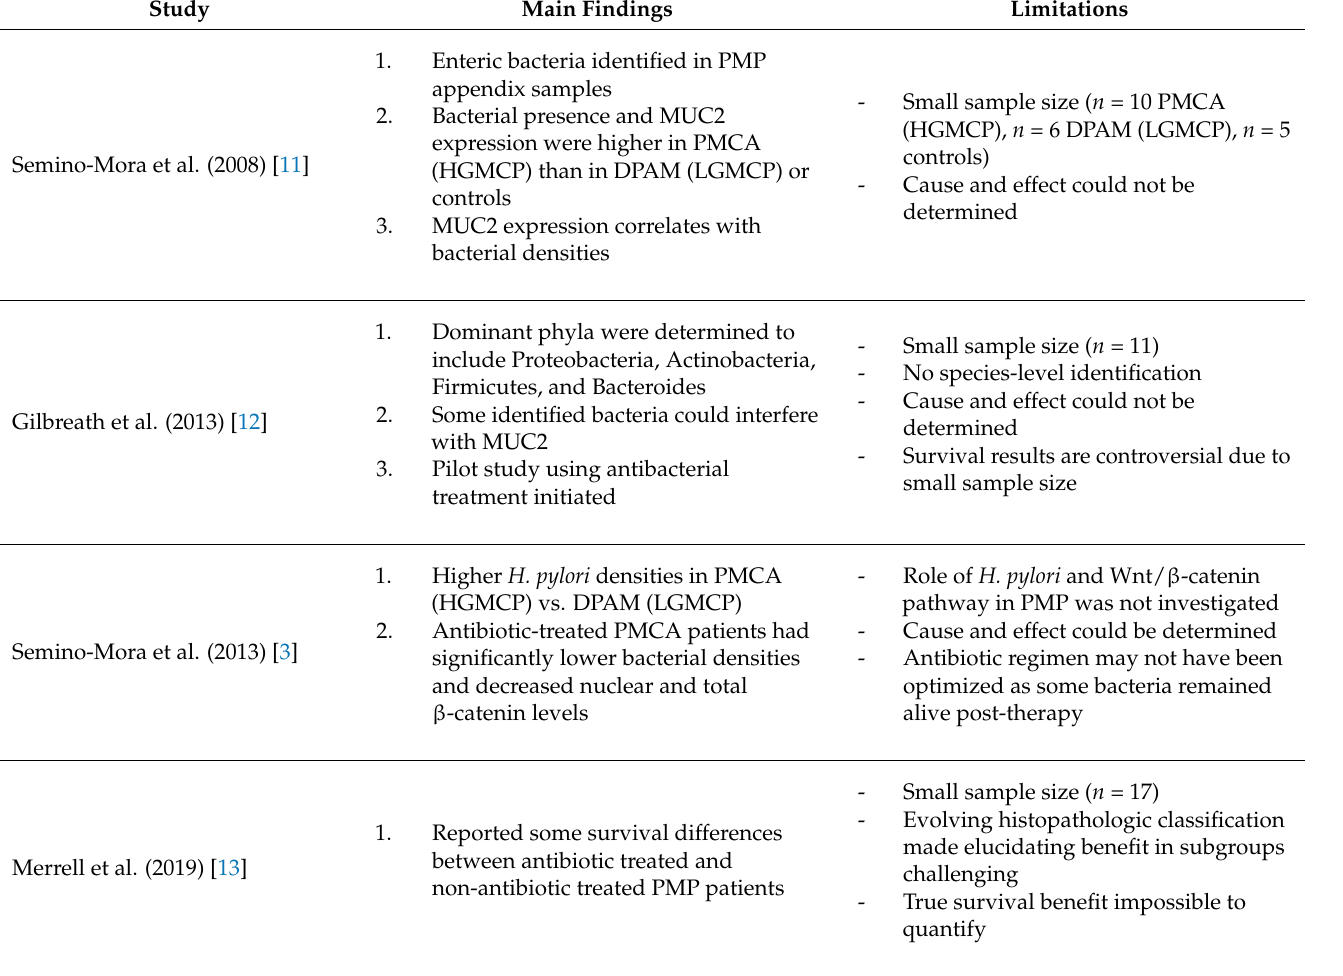
Table 2. Summary of studies investigating bacteria and